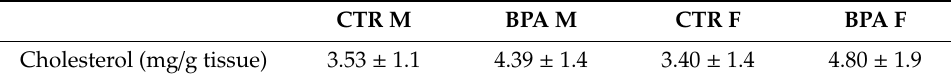
Table 2. Brain cholesterol content in prenatal BPA- or Vehicle-exposed rat fetuses. CTR M BPA M Cholesterol (mg / g tissue)